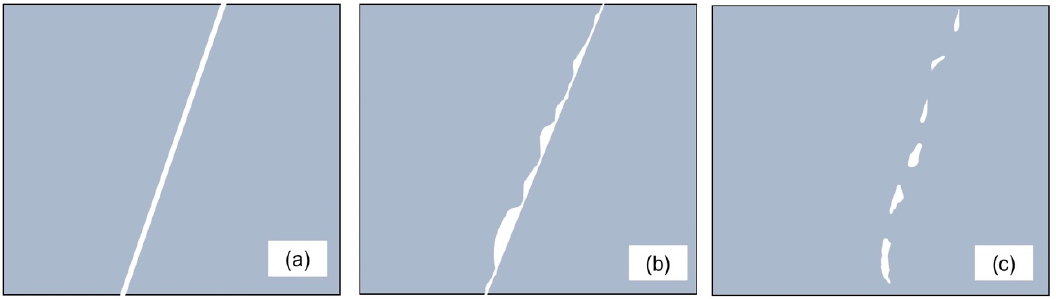
Figure 4. Schematic of the formation and evolution of cracks in the glassy layer (left side of each graph refers to the probe side): ( a ) formation of initial cracks; ( b ) the probe-side surface of the crack had a lower temperature (contributed by the interfacial thermal resistance of the crack) and larger shrinkage ratio upon cooling; ( c )some parts of the crack interface melted (molten flux side), and isolated pores with irregular shapes formed (the white areas in ( c ) are pores).